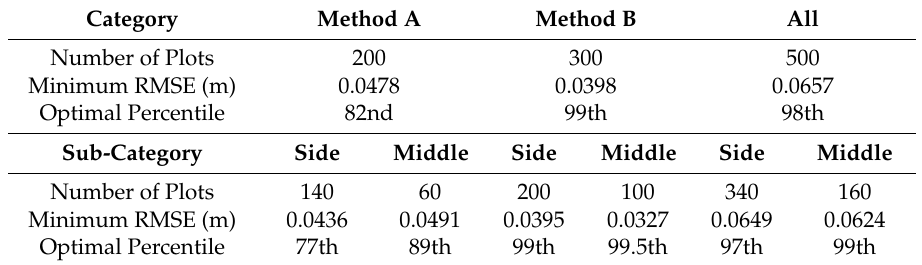
Table 3. Effects of manual method and plot position on minimum RMSE of processed LiDAR point